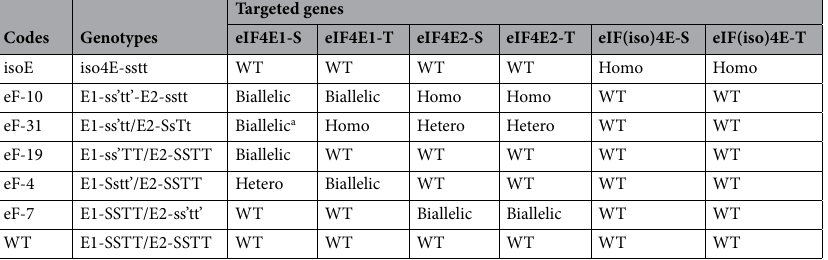
Table 1. Genotype of mutant lines used for PVY infection. a Sanger sequencing revealed a null mutation in one allele and a single-amino-acid deletion in the other, resulting in a partial loss of gene function.